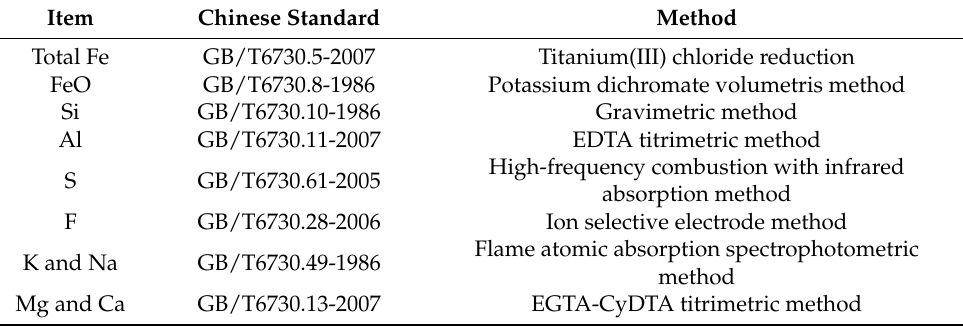
Table 3. The chemical methods used to analyze the chemical compositions of samples.